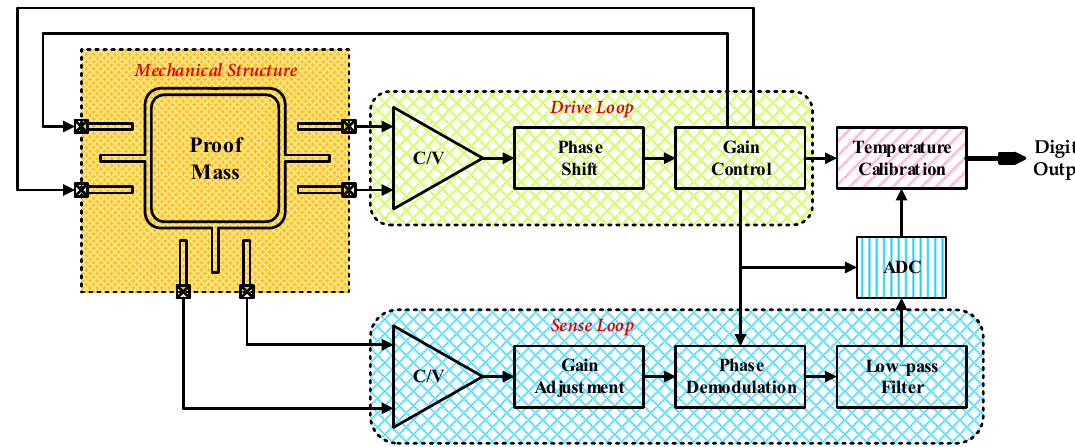
Figure 4. Systematic design of the proposed interface for MEMS gyroscopes.